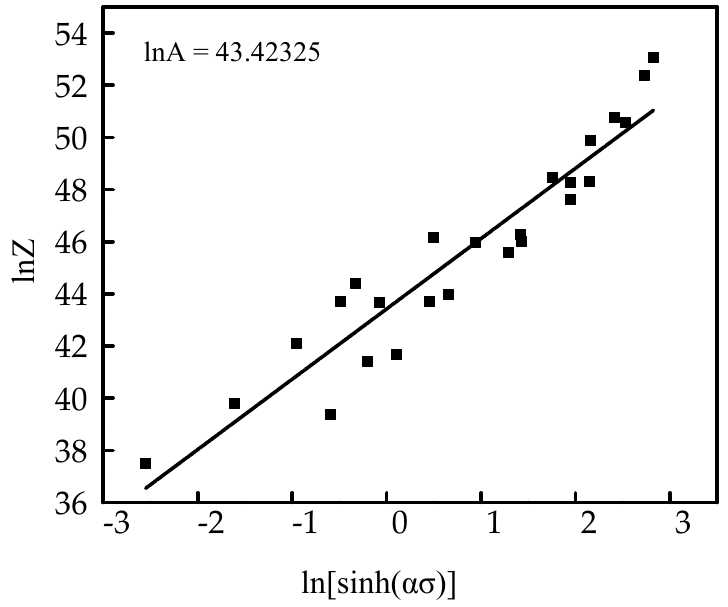
Figure 7 is the relation curve of ln 𝑍 − ln[sin h(𝛼𝜎)] when the true strain is 0.69.